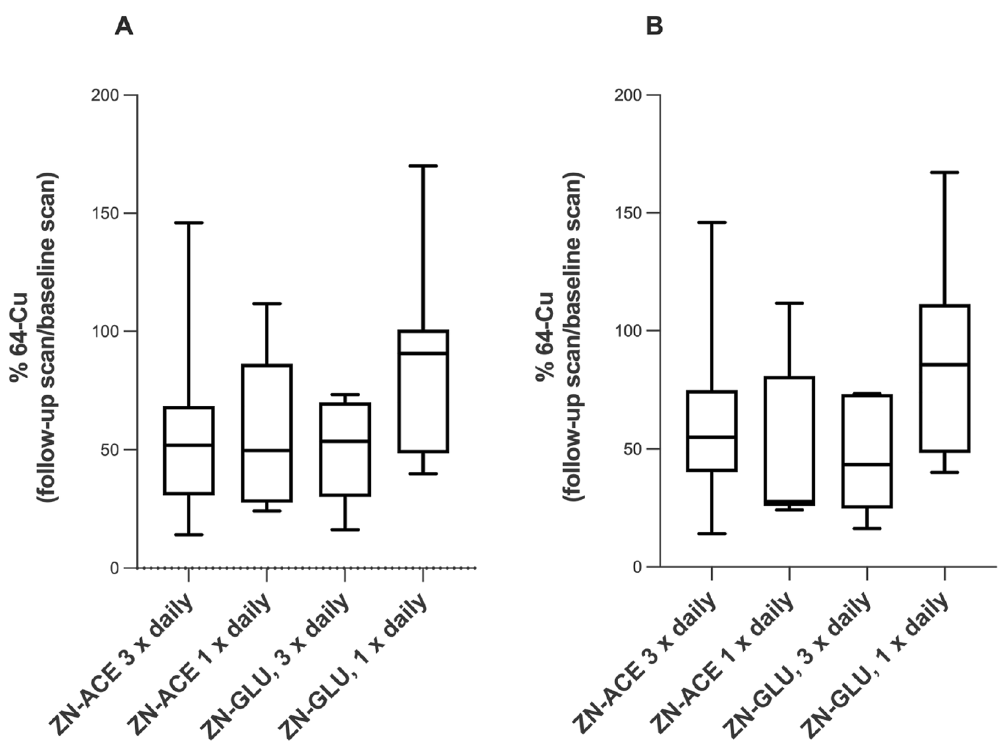
Figure 3. Box plot of hepatic copper-64 (mean hepatic SUV) as percentage on end-of-treatment scan compared to baseline scan. ( A ) All completed participants. ( B ) Per-protocol